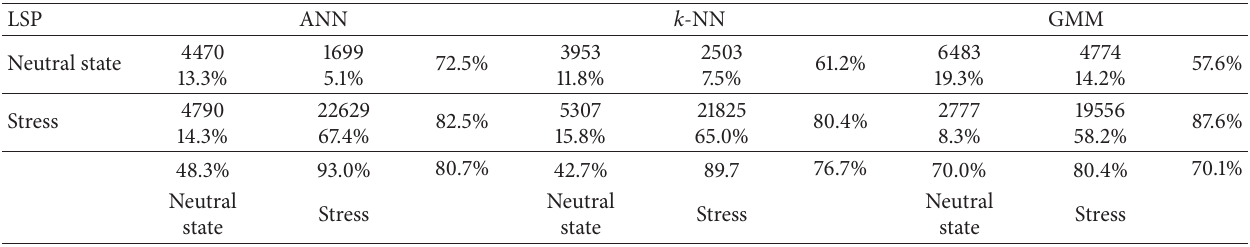
Table 4: Performance results of classifiers for prosodic features.